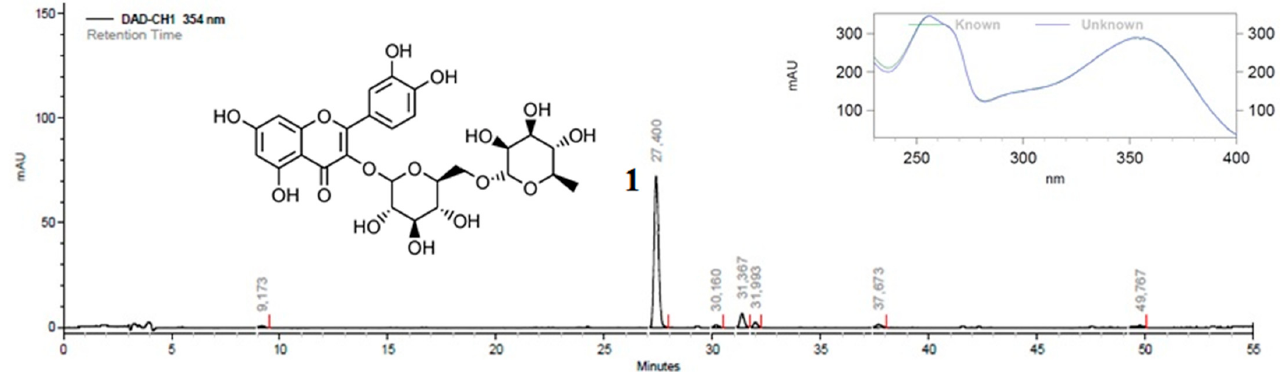
Figure 4. High-performance liquid chromatography (HPLC) profile of ethanol extract of Hippeastrum stapfianum leaves (EE) at 354 nm and UV spectra (230–400 nm) of peak number 1 and rutin overlapped. Table 1. Metabolites of Hippeastrum stapfianum identified by gas chromatography–mass spectrome- try (GC-MS). 226 (100), 227 (59), 250 (19), 27 (187), 286 (13),